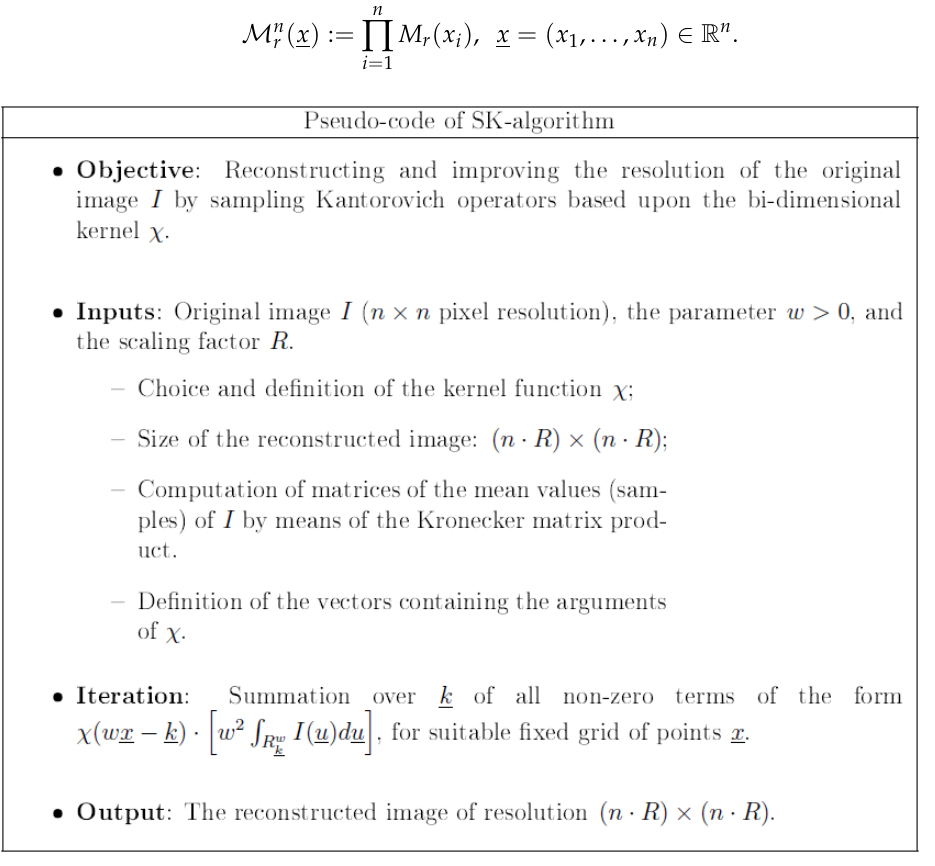
Figure 2. Pseudo-code of the SK